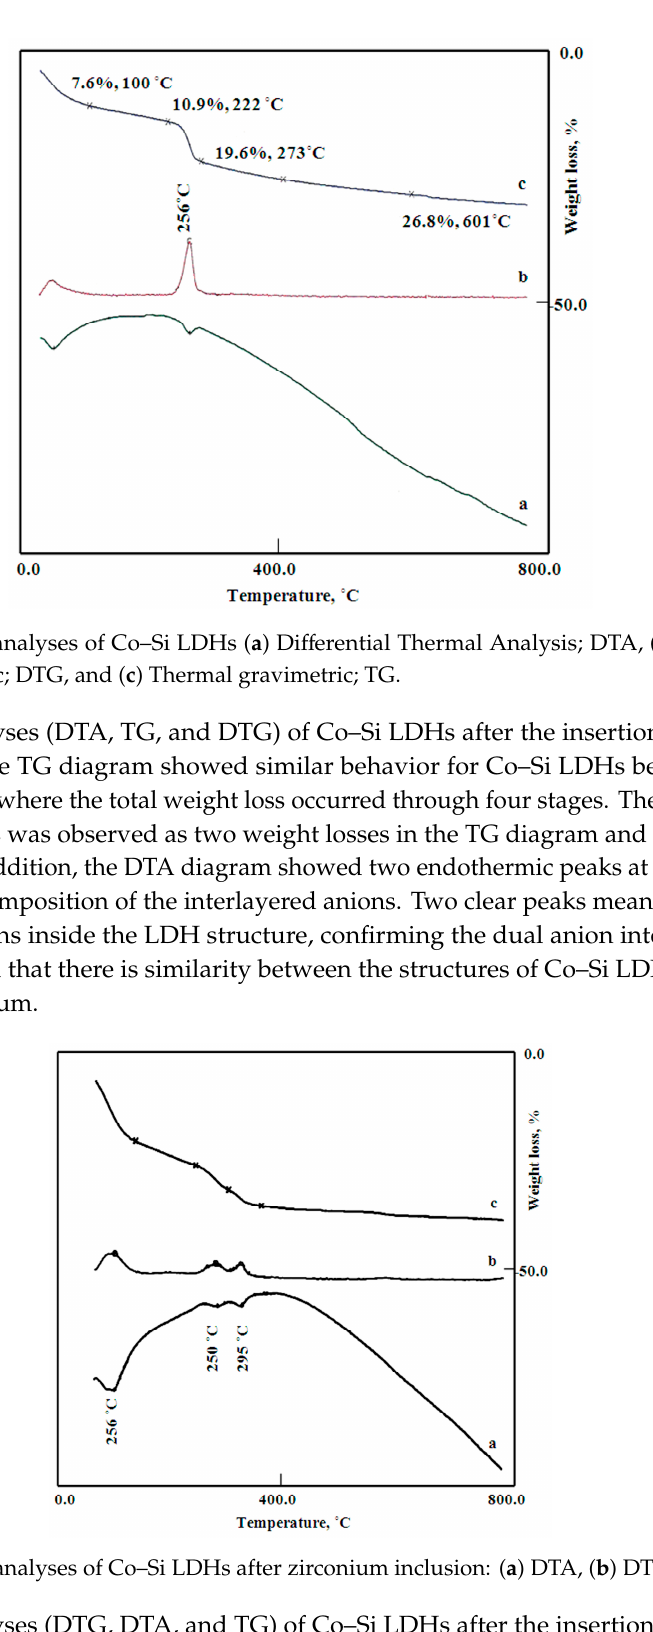
Figure 7. Thermal analyses of Co–Si LDHs after zirconium and titanium inclusion: ( a ) TG, ( b ) DTG, and ( c ) DTA. 3.4. Infrared Spectra To identify the intercalated anions, an infrared spectrum of Co–Si LDHs after the insertion of zirconium is displayed in Figure 8a. Cyanate anions (N ≡ C–O − ) were observed by the appearance of a clear band at 2203 cm − 1 corresponding to the vibrational mode of cyanate. The nitrate anions were also detected by observing two bands at 1384 cm − 1 and 1495 cm − 1 [28]. Strong and sharp bands were observed around 2856 cm − 1 . These bands are attributed to the stretching mode of O–H belonging to the molecules of interlayered water that hydrogen-bonded to interlayered anions [28]. The sharpness of these bands suggests that there is a large number of water molecules hydrogen-bonded with the cyanate anions inside the interlayered space. This speculation was confirmed by the bending mode band of water molecules that was observed clearly close to 1637 cm − 1 [29]. After inserting both zirconium and titanium into Co–Si LDHs, the absorption peak at 2204 cm − 1 shifts to 2217 cm − 1 , indicating that the intercalated anions became isocyanate anions ( − N=C=O), as shown in Figure 8b [30]. It means that cyanate anions transformed to isocyanate anions, according to the balance (N ≡ C-O − ↔ − N=C=O).